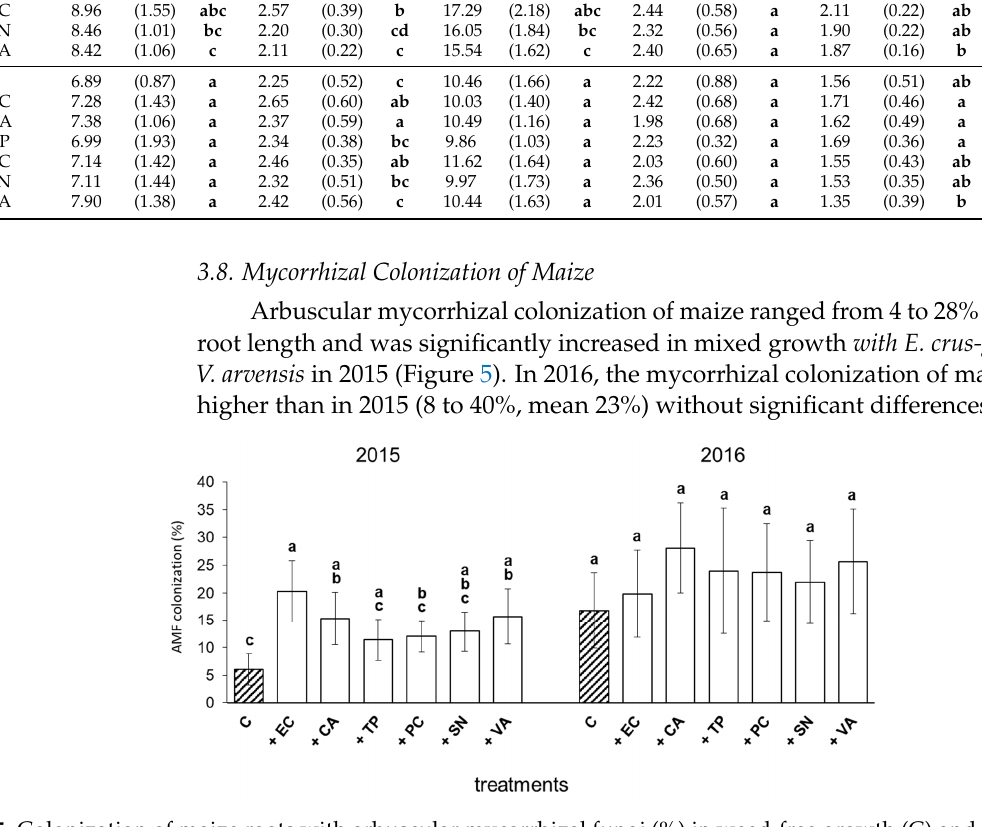
Figure 5. Colonization of maize roots with arbuscular mycorrhizal fungi (%) in weed-free growth (C) and mixed growth with weeds in a pot experiment (6 kg of a P deficient loamy sand per pot) under semi field conditions in 2015 and 2016. Values are expressed as means ± SD. Lower letters indicate significant differences ( p < 0.05, Tukey test, n = 42). (C: control, +EC: maize + Echinochloa crus-galli, +CA: maize + Chenopodium album , +TP: maize + Tripleurospermum perforatum , + PC: maize + Polygonum convolvulus , + SN: maize + Solanum nigrum , + VA: maize + Viola arvensis )